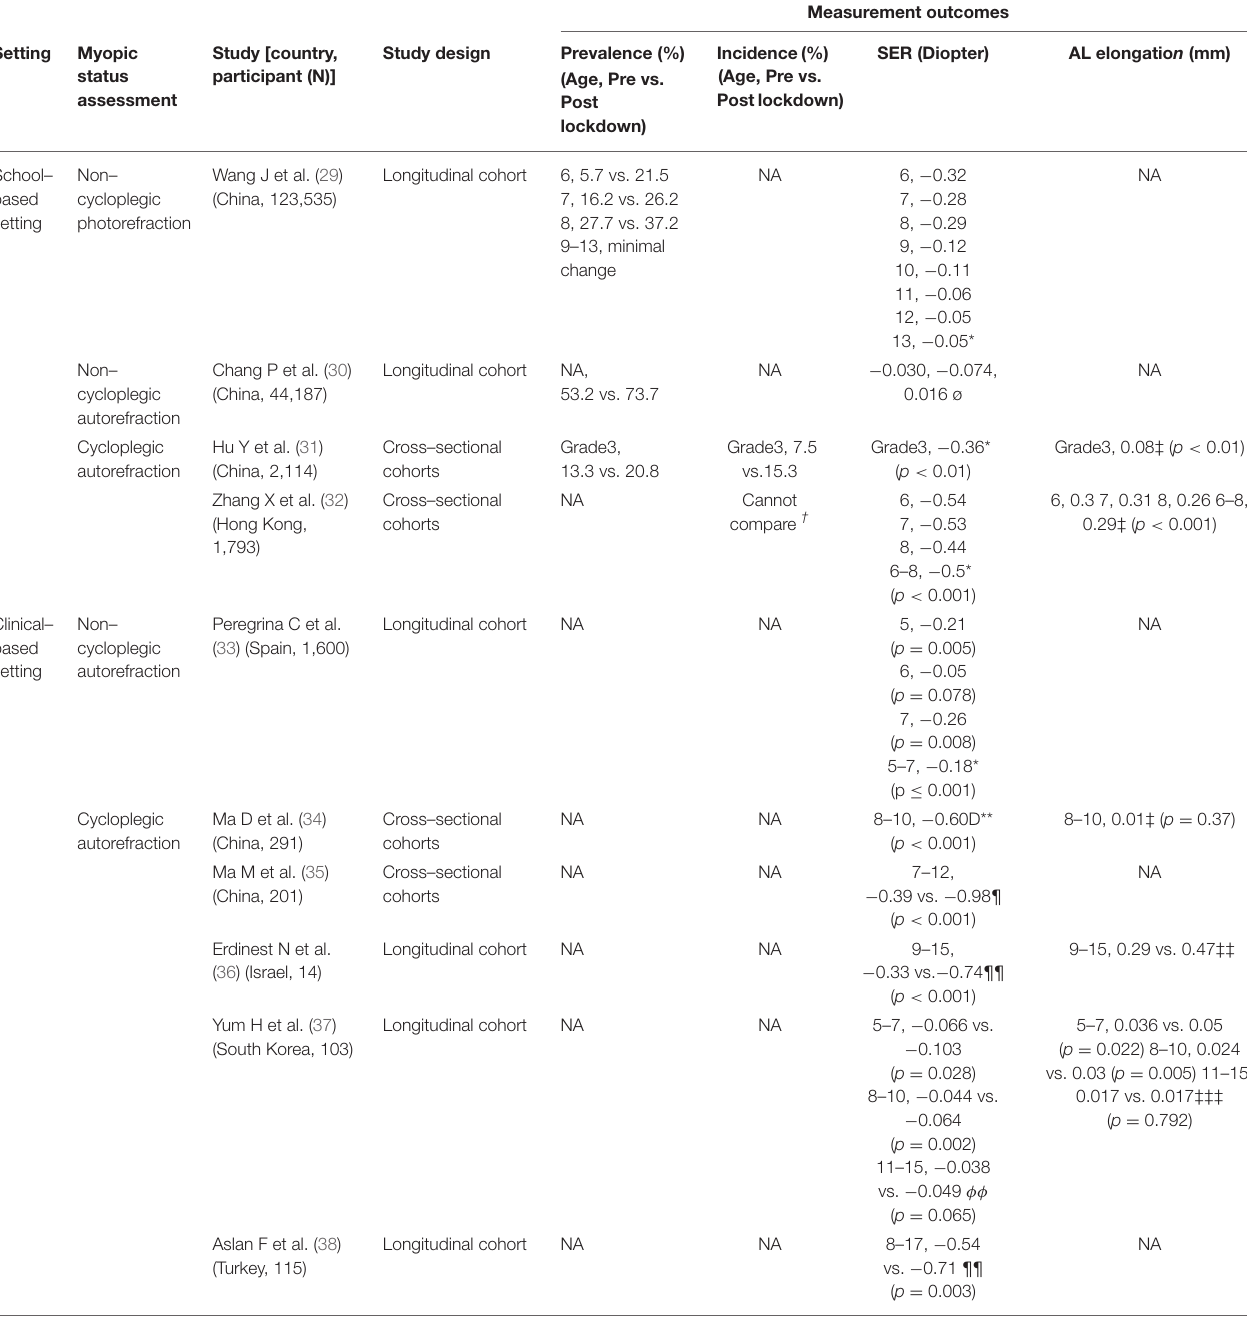
TABLE 1 | The selected studies without myopia preventive interventions, their characteristics and measurement